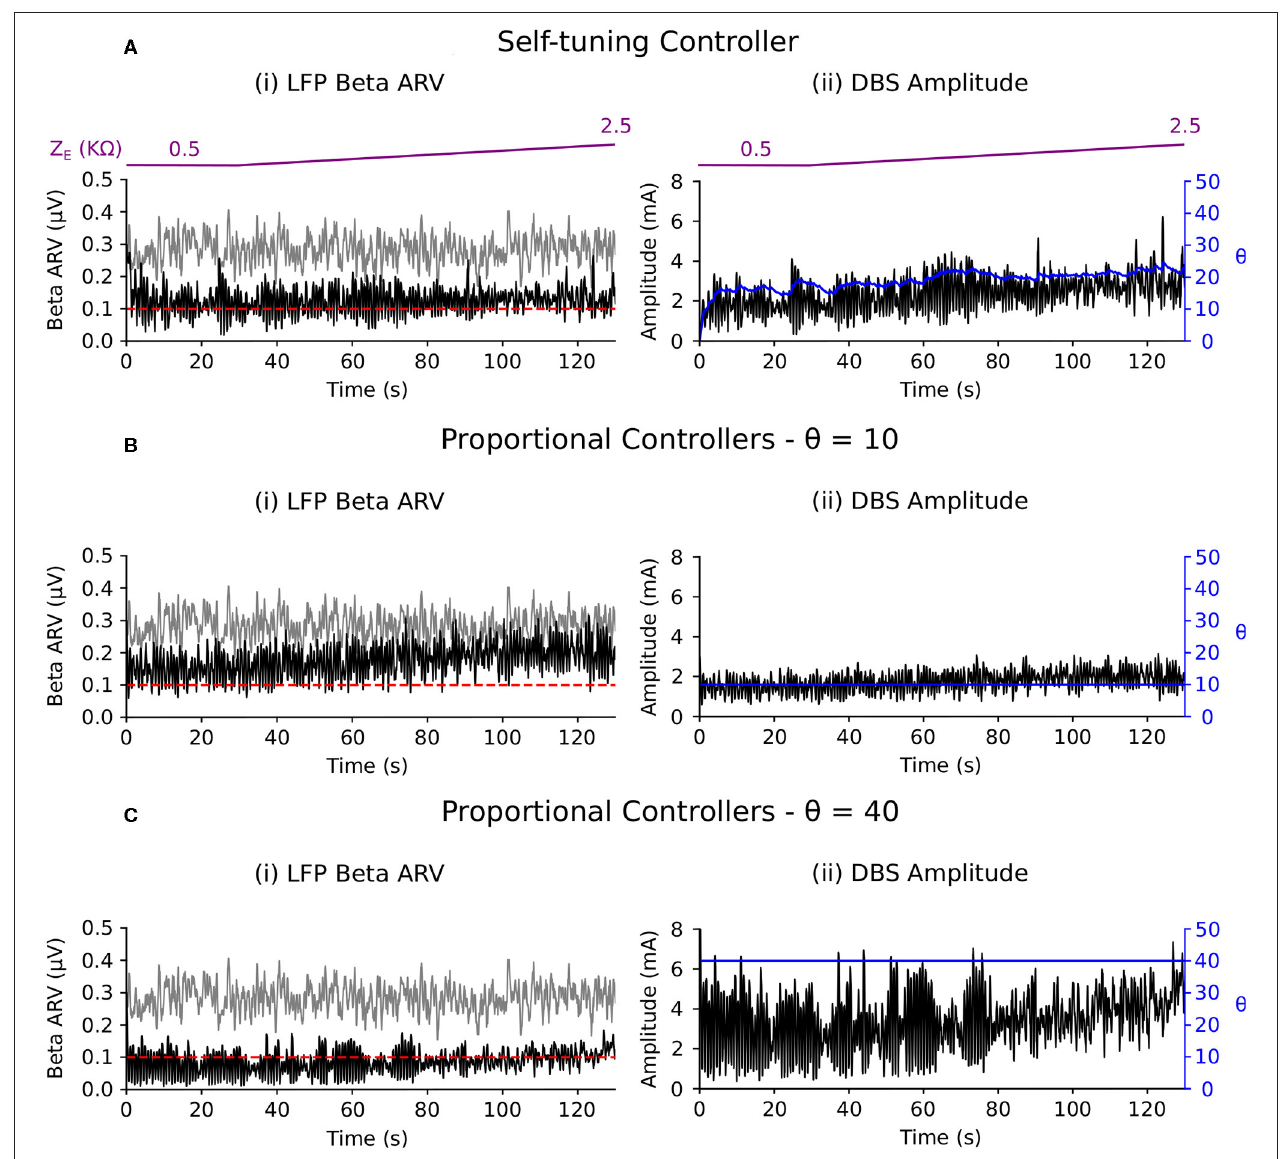
FIGURE 8 | Performance comparison of self-tuning and proportional controllers in response to electrode impedance variations in the conductance-based model. The beta ARV target value was fixed to 0.1 µ V and the background beta-band activity was fixed to its maximum value for the duration of the simulation. The electrode impedance was fixed at 0.5 K (cid:127) during the 0–30 s period and was then linearly increased from 0.5 to 2.5 K (cid:127) over the 30–130 simulation period. The electrode impedance variation is illustrated by the purple bar at the top of the figure. Left panels illustrate the target value (dashed red), the beta ARV measured from the STN LFP when DBS was off (gray) or on (black), where the DBS amplitude was modulated by the corresponding controller. Right panels illustrate the time evolution of the DBS amplitude (black) and controller gain θ (blue) during simulation. (A) Self-tuning DBS controller with τ θ = 100 ms and σ = 0.00875. (B) Proportional controller with a fixed gain value of θ = 10. (C) Proportional controller with a fixed gain value of θ =